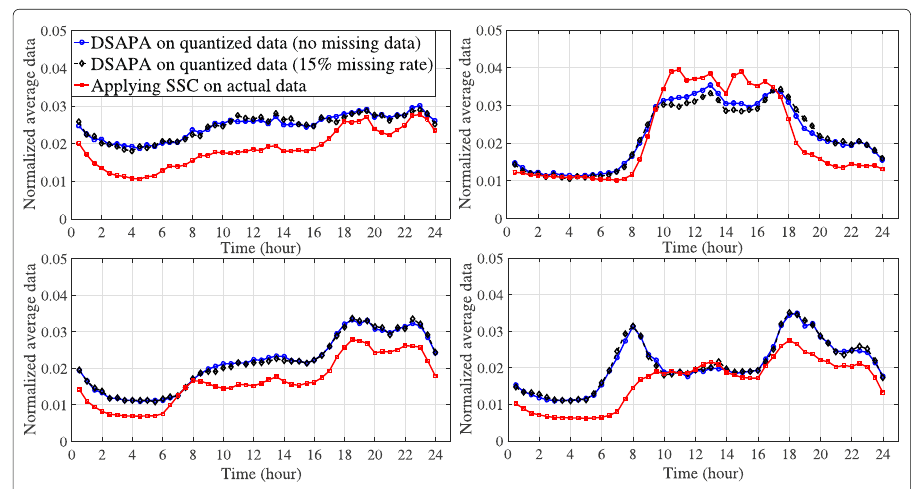
Fig. 6 Average consumptions of four different groups in 1 day (actual and recovered by DSAPA)